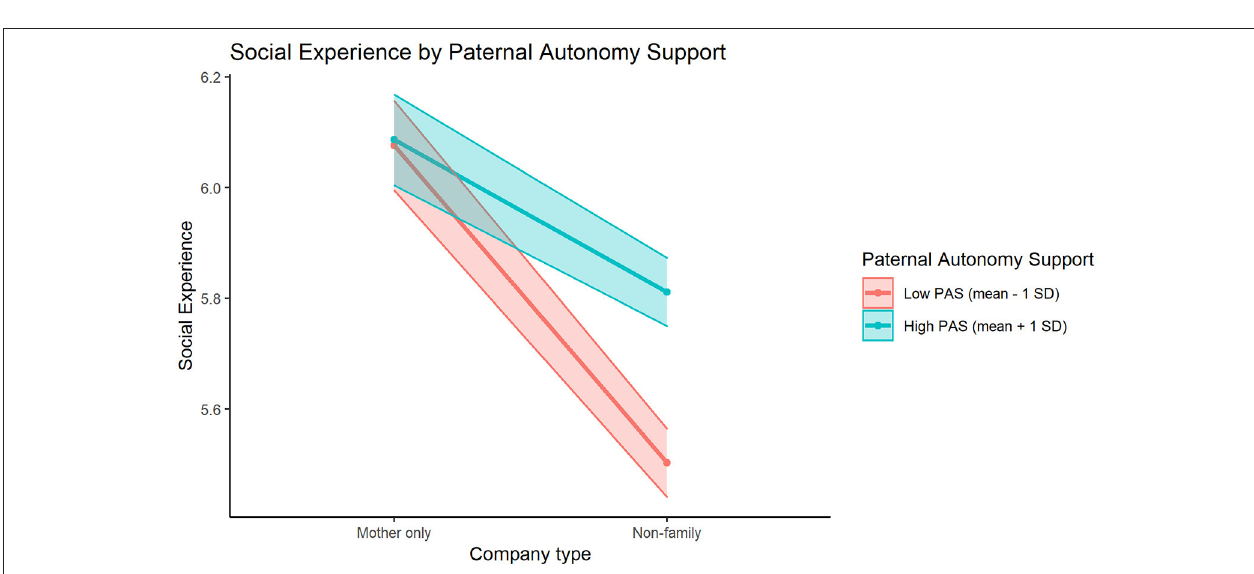
FIGURE 2 | The significant interaction effect between PAS (Paternal Autonomy Support) and maternal vs. non-family company in the prediction of mean social experience, for participants ± 1 standard deviation of the Paternal Autonomy Support mean